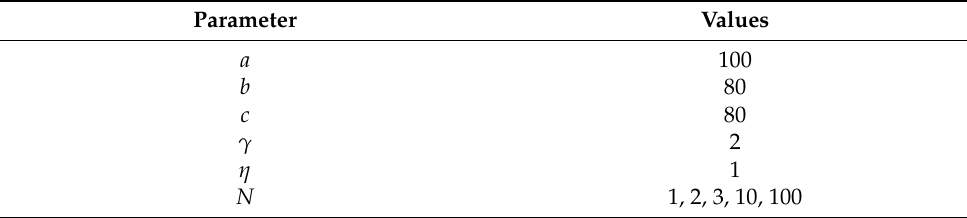
Table 6. Experiment